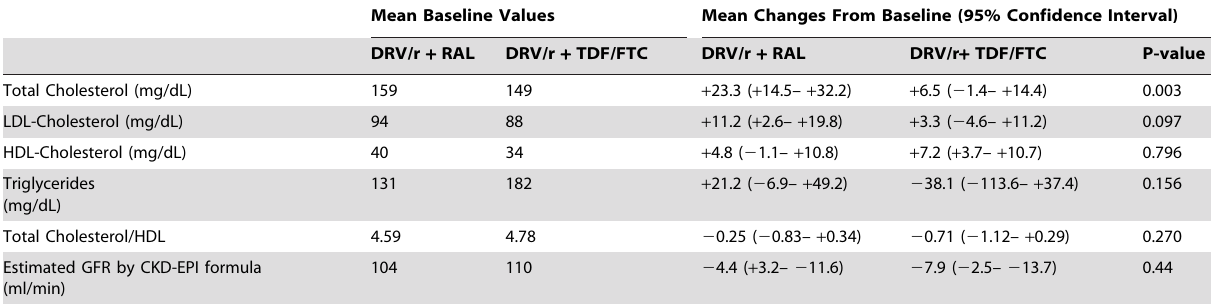
(Figure 2B). Patients on the RAL arm achieved more rapid table 2. The proportion of patients with baseline plasma HIV-1 virologic suppression than participants in the TDF/FTC arm; of the patients remaining in the study at week 48, 27/34 (79%) in the Table 2. Lipid parameters and Renal Function: Baseline values and changes at week